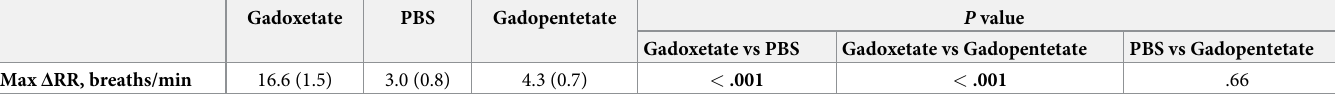
Fig 4. Differences in the time course of the respiratory rate among the different materials. Note.—Error bars represent standard errors (n = 9 rats per group). IVC-Gadoxetate, gadoxetate disodium injection into the distal inferior vena cava (IVC); IVC-PBS, phosphate-buffered saline injection into the distal IVC; IVC-Gadopentetate, gadopentetate dimeglumine injection into the distal IVC. https://doi.org/10.1371/journal.pone.0265588.g004 The value of the maximum elevation in RR was significantly higher in the ascending aorta group than in the distal IVC group and in the descending aorta group, ( P = .017 and < .001, respectively). As shown in the representative example, DSA with iodinated contrast agent injected into the distal IVC required approximately 0.88 sec to visualize the IVC at the level of the right renal vein, and 4.25 sec to visualize the ascending aorta and carotid arteries (Fig 5C). In addition, DSA with iodinated contrast agent injected into the descending aorta required approximately 2.88 sec to visualize the IVC at the same level (Fig 5D). Gadoxetate disodium administration in rats: effect of dilution with 5% albumin instead of PBS. In addition, after injection of PBS-diluted gadoxetate disodium into the ascending aorta in 7 rats, the maximum elevation in RR was approximately 24.1 breaths/min at 15.7 sec, and tachypnea started at 9.9 sec from the start of injection (Fig 6 and Table 5). On the other hand, with 5% albumin-diluted gadoxetate disodium in 7 rats, the maximum elevation in RR was approximately 17.0 breaths/min at 18.1 sec, and tachypnea started at about 13.0 sec. With dilution with 5% albumin, the starting time was significantly delayed ( P < .001), and the maxi- mum elevation in RR was significantly delayed and suppressed ( P = .020 and = .031, respectively). Table 3. Statistical analysis of the maximum elevation in the respiratory rate among different